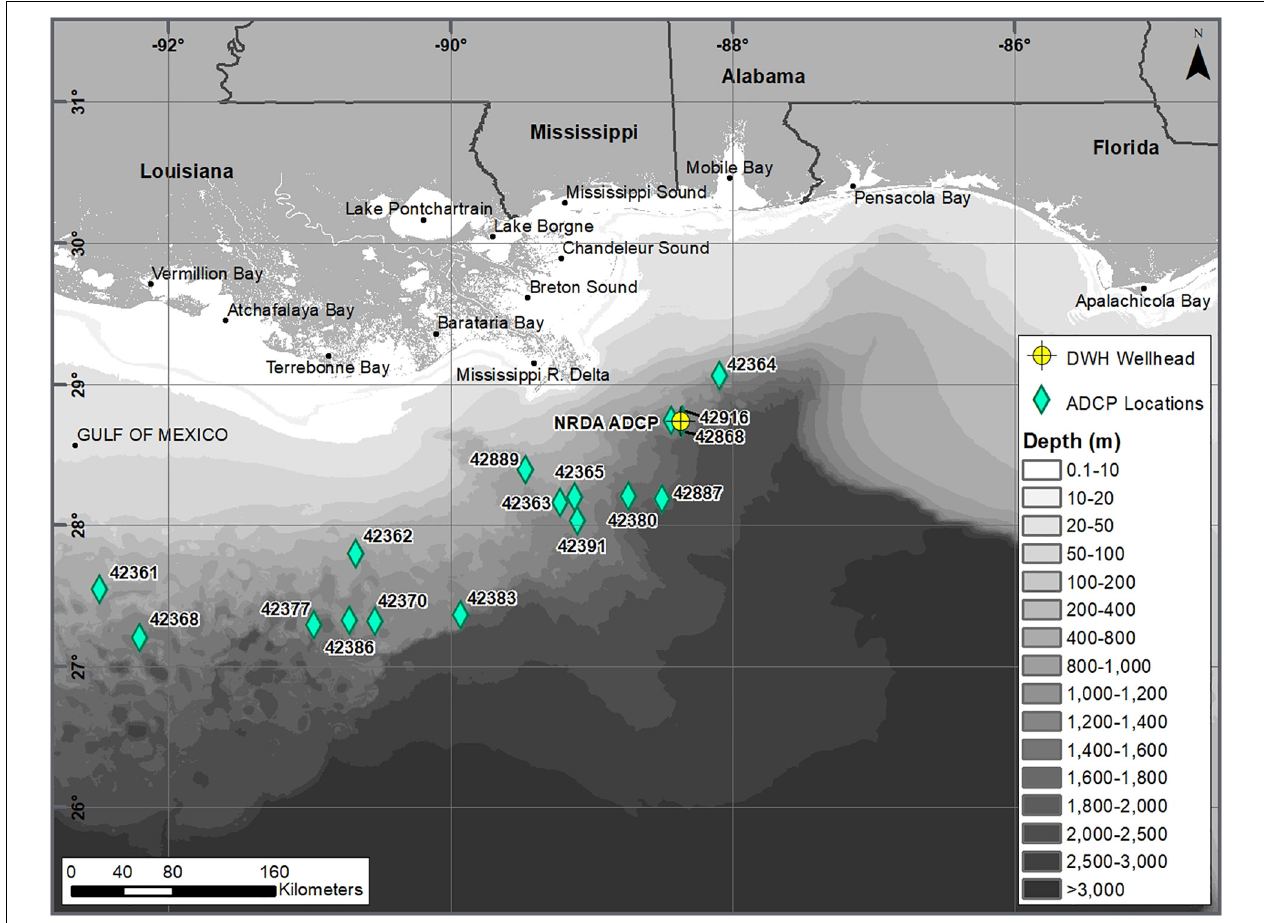
FIGURE 1 | Map of the northern Gulf of Mexico region exposed to floating and shoreline oil from the DWH spill, showing 17 ADCP locations. (The DWH wellhead is indicated by the crossed circle. Three ADCP locations are close to the